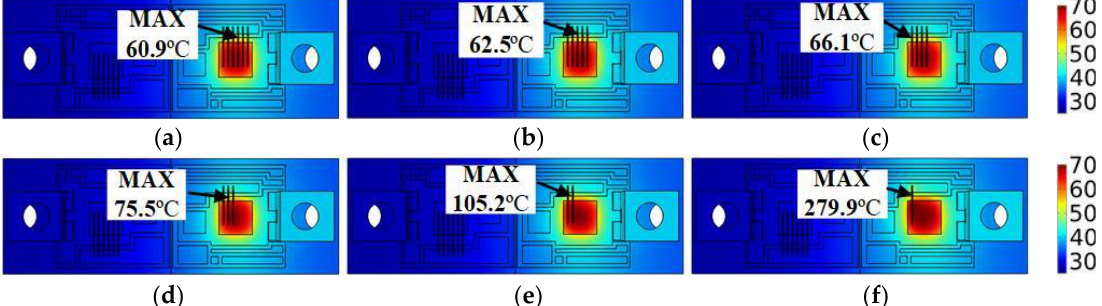
Figure 6. Temperature distribution of IGBT module with different bond wires removed under 40 A ( a ) 0 wire ( b ) 1 wire ( c ) 2 wires ( d ) 3 wires ( e ) 4 wires ( f ) 5 wires.